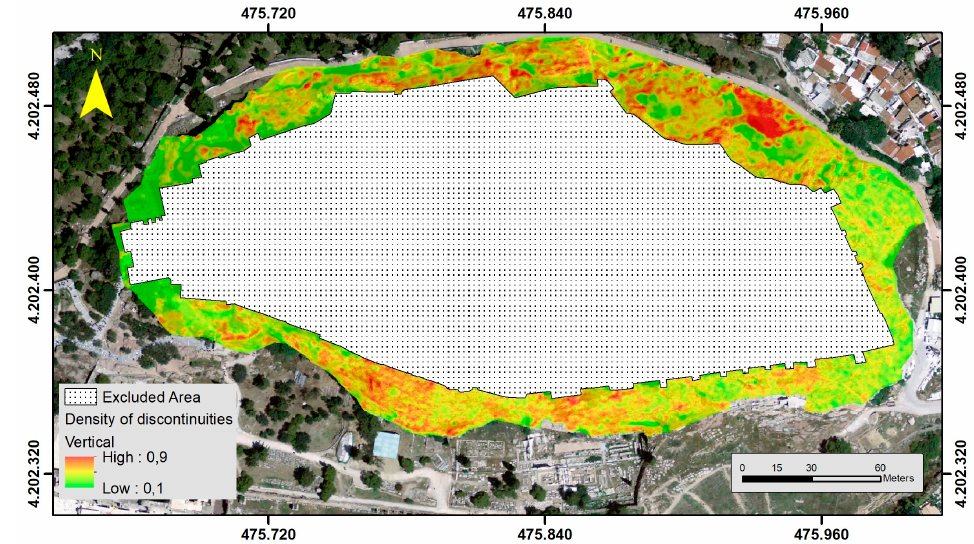
Figure 7. Instability related parameters (normalized): Density of discontinuities—vertical.